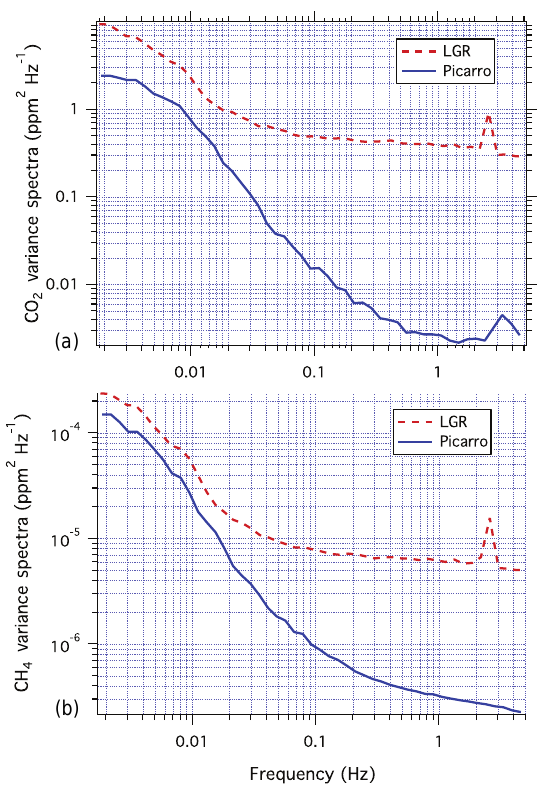
Figure 7. Mean variance spectra of dry CO 2 (top) and CH 4 (bot- tom) from the air–water wind sector during the Picarro (dry) vs. LGR (wet) period. The LGR shows significantly greater variance, especially at high